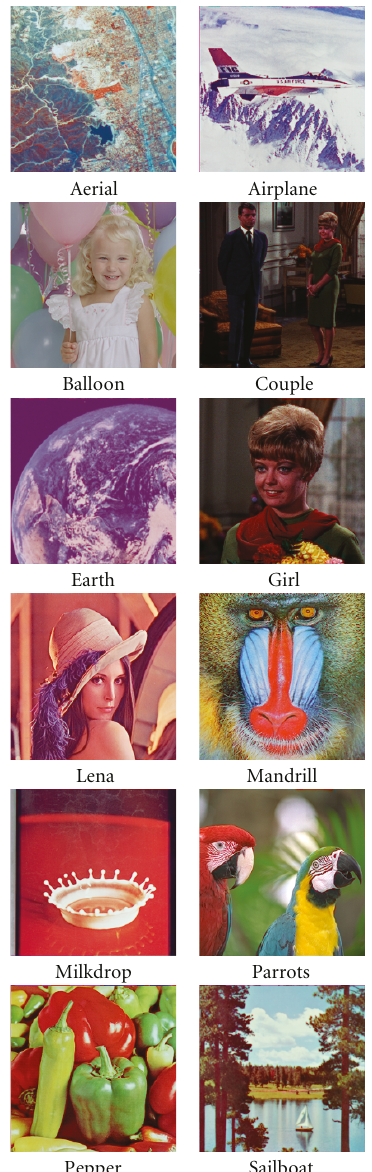
Figure 11: Watermarked images (MTF, maxQ). Figure 12: Watermarked images (JPEG75,